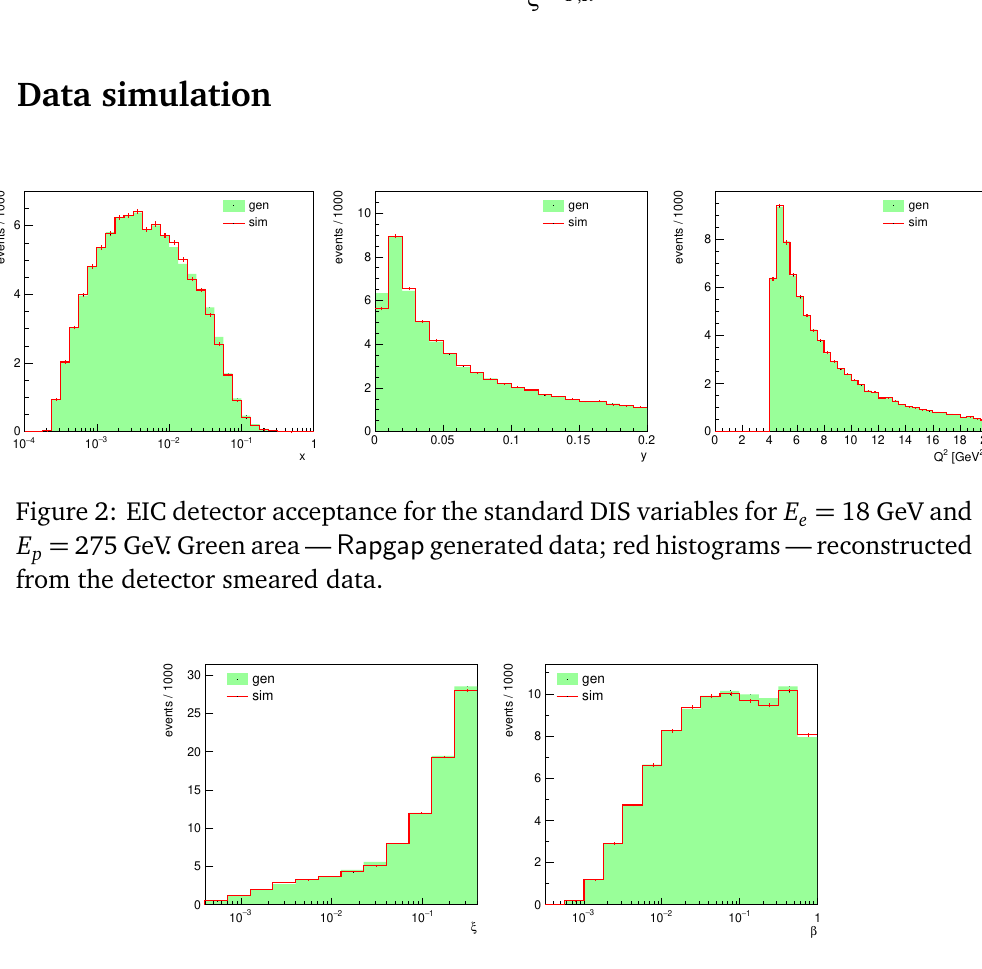
Figure 3: Same as Fig. 2 but for diffractive variables ξ and β